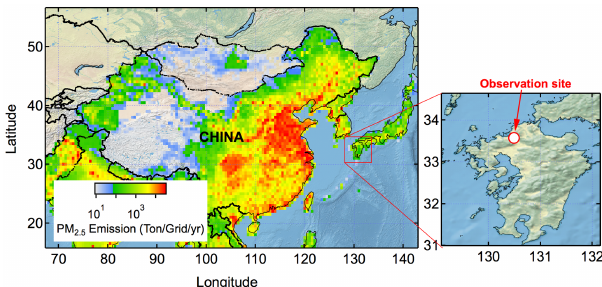
Figure 1. Geographic location of the observation site and annual anthropogenic emissions of primary PM 2 . 5 in East Asia according to REAS2.0 emission inventory (Ohara et al.,